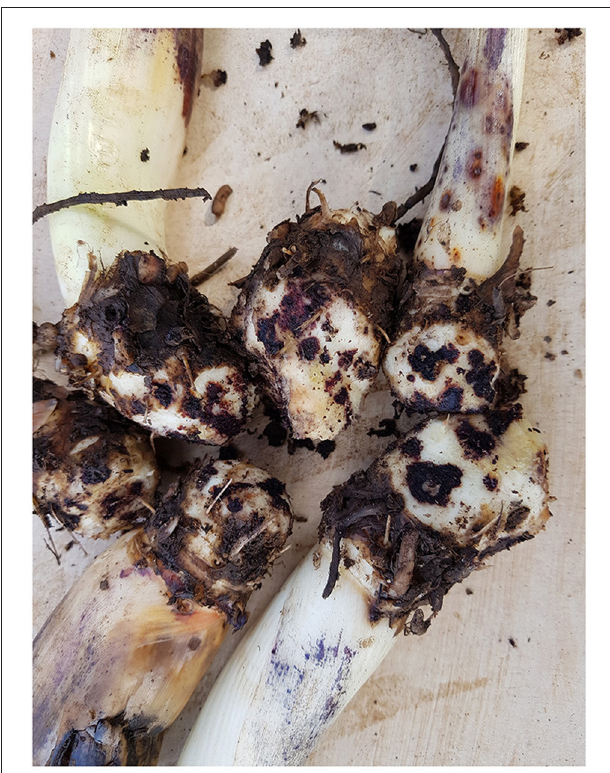
FIGURE 4 | Extensive lesioning on enset suckers collected from markets and farms in